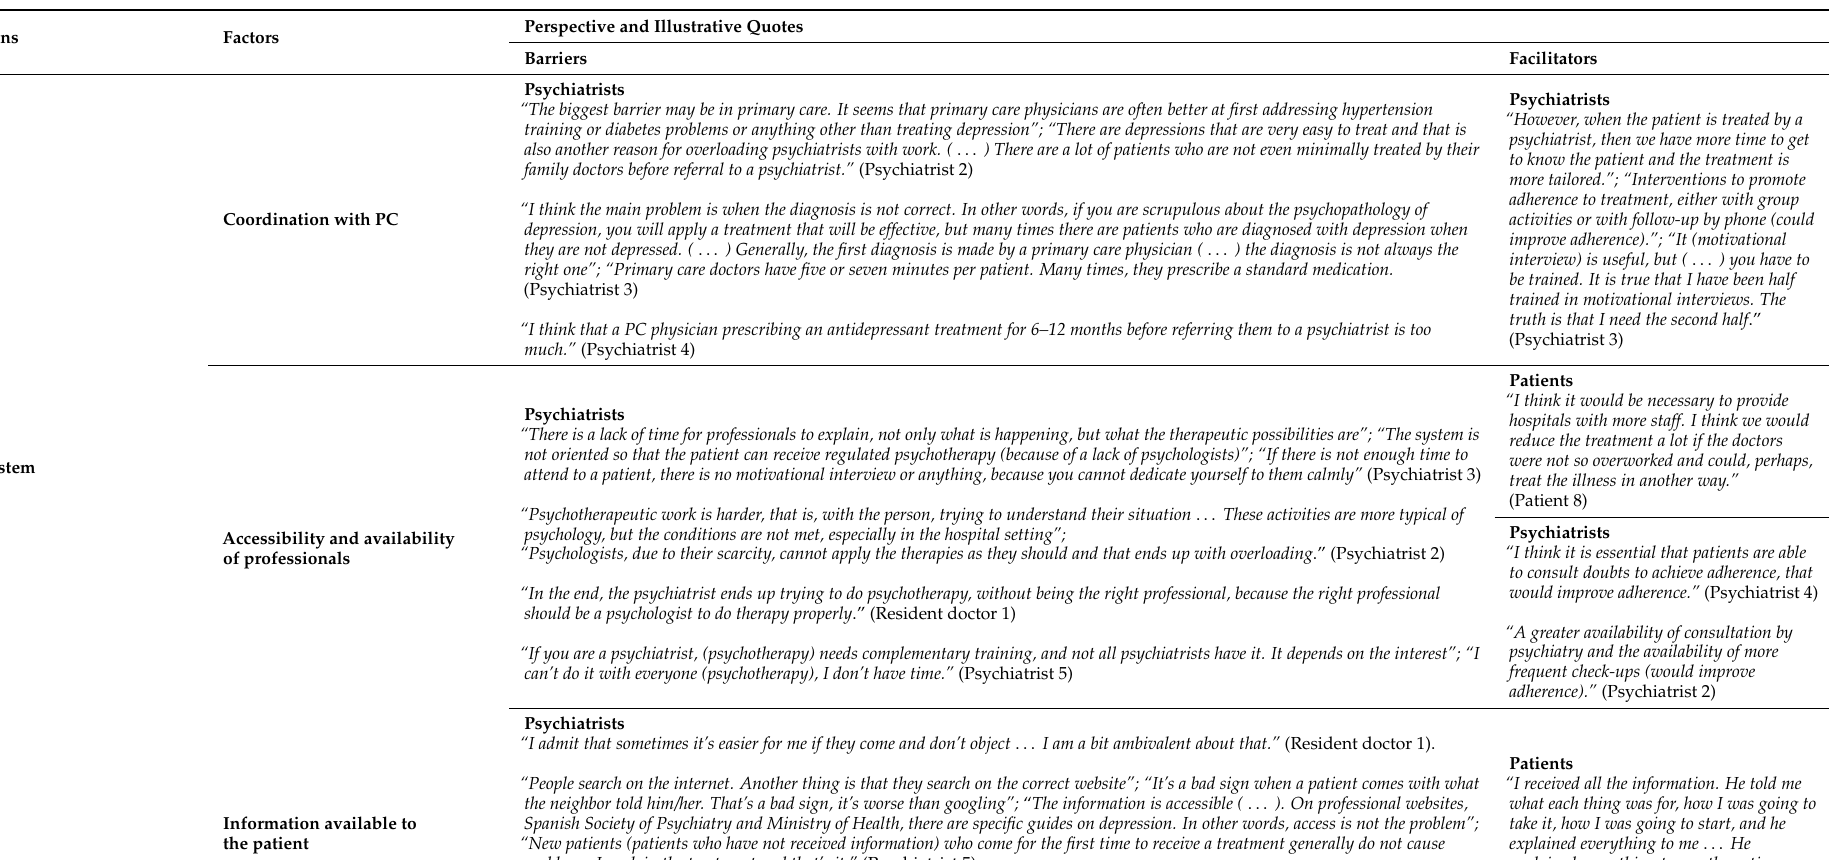
Table 4. Modifying factors of therapeutic adherence identified by professionals and